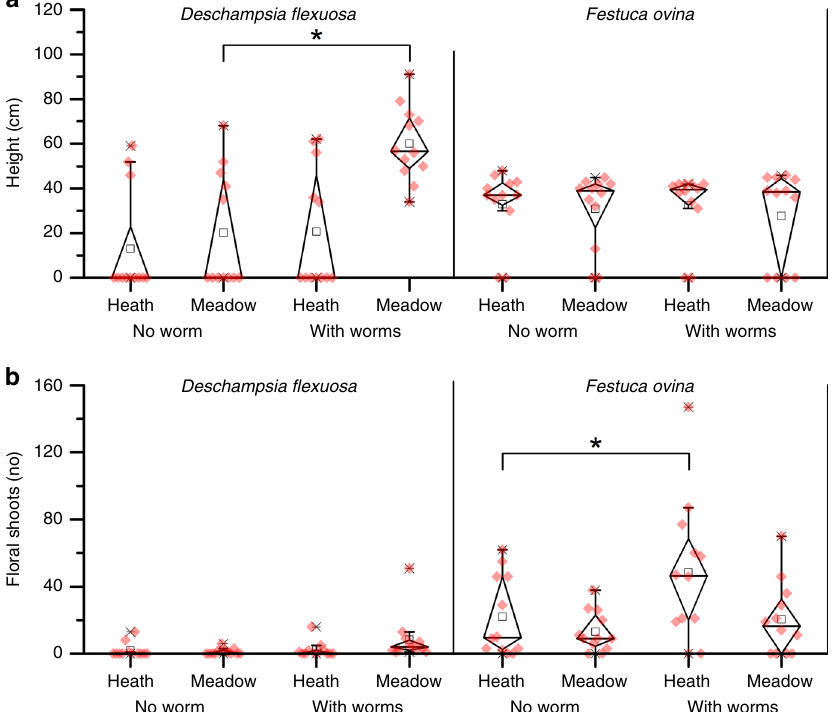
Fig. 4 Aboveground plant growth responses to earthworm additions. Boxplot showing a the maximum height and b the highest number of fl oral shoots (lower panel) of graminoids ( D. fl exuosa and F. ovina ) per mesocosm. Diamond box indicate the 25%- to 75%-percentiles (whiskers show 99% percentile) and black rectangle the median value. Mesocosms lacking the studied plants are given a value of 0. Signi fi cant effects are indicated with *( P < 0.05). Source data are provided as a Source Data fi le.